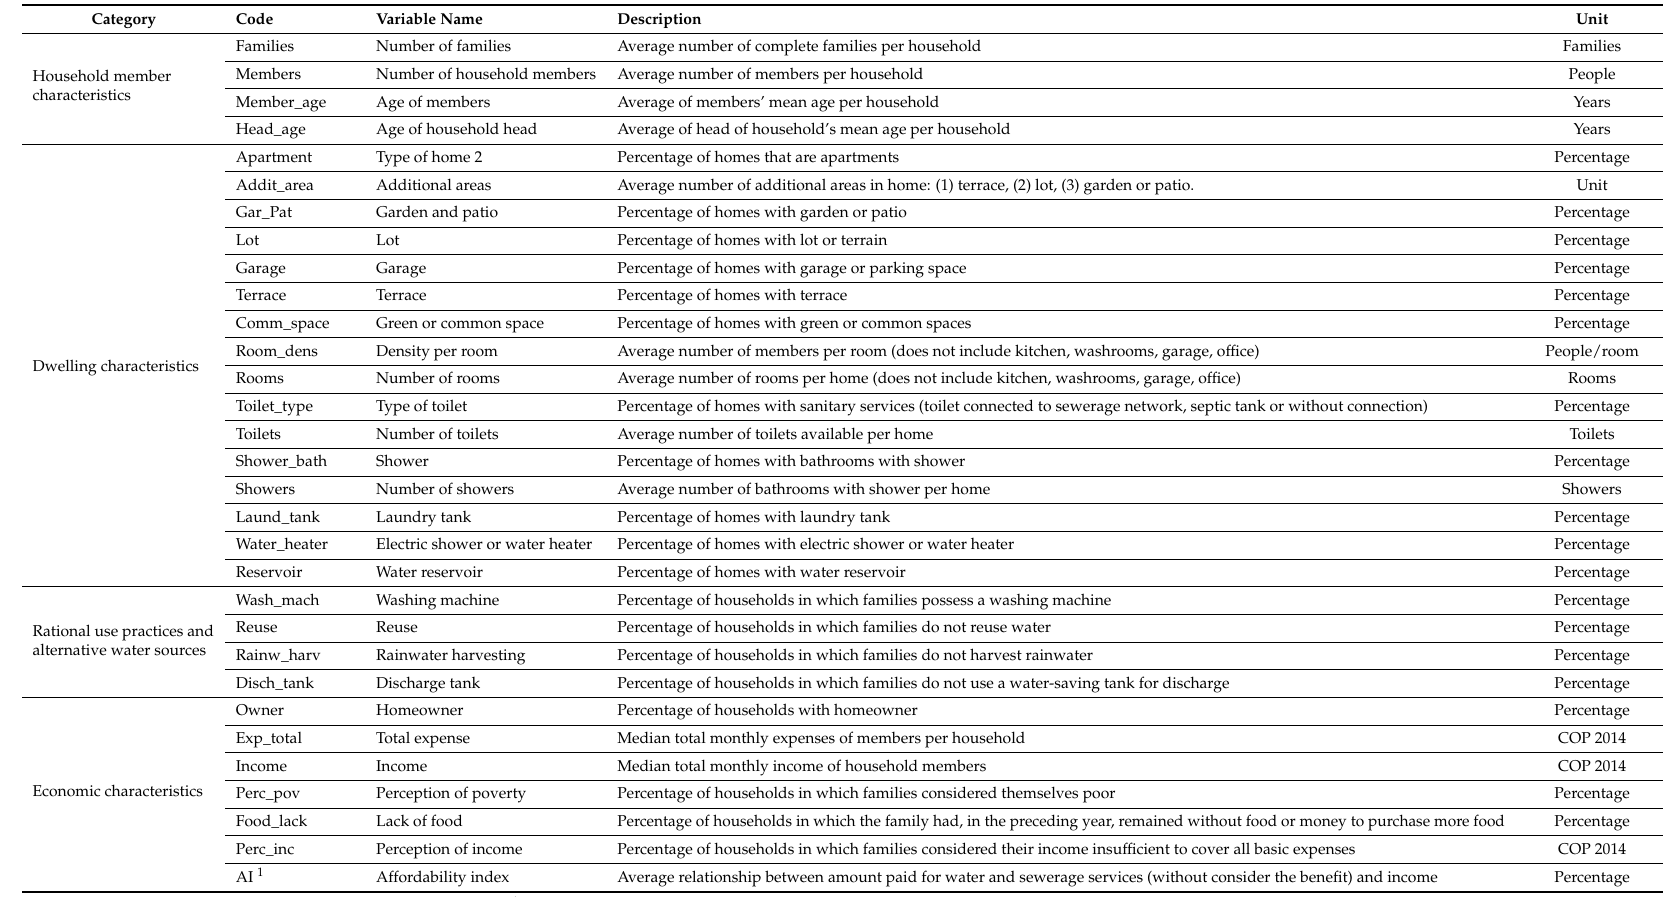
Table A9. Variables of the Multipurpose